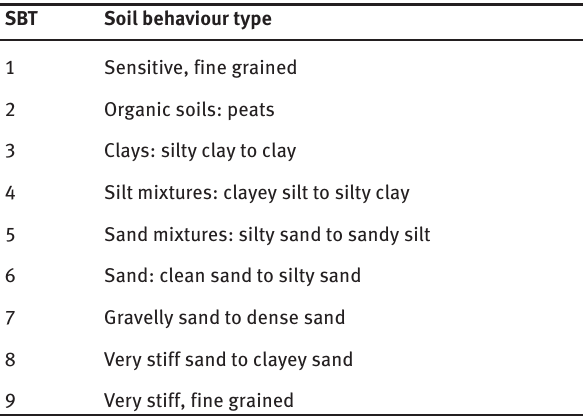
Table 2: Numbers of subdivisions and corresponding Soil Behaviour Types [11]